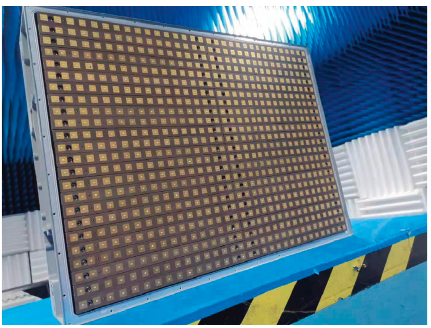
Figure 12: The two-dimension phased array utilized for experiment.